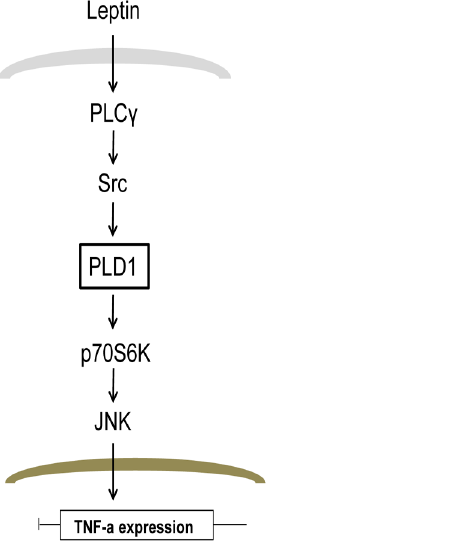
Figure 6. PLD1 activation is crucial for leptin-induced TNF- a expression and production in Raw264.7 cells. Our novel finding in this experiment is that leptin-induced TNF- a expression is controlled by PLD1